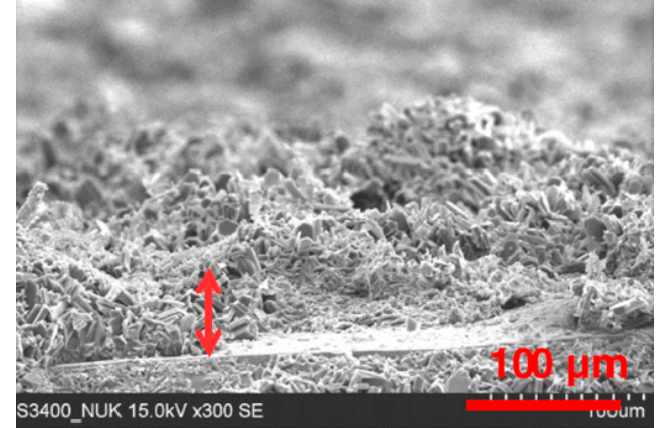
Figure 8. Cross-section SEM image of the zeolite coating produced by non-optimal hydrothermal synthesis [35]. Reprinted with permission from Elsevier.